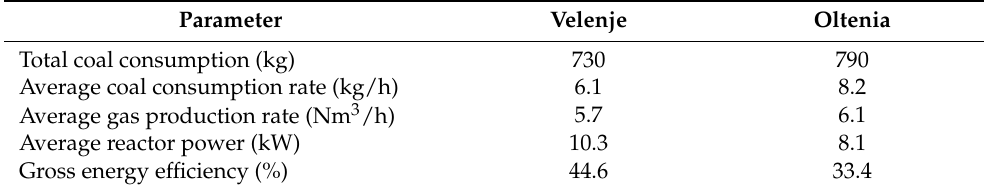
Table 3. Balance calculations for the Velenje and Oltenia atmospheric pressure